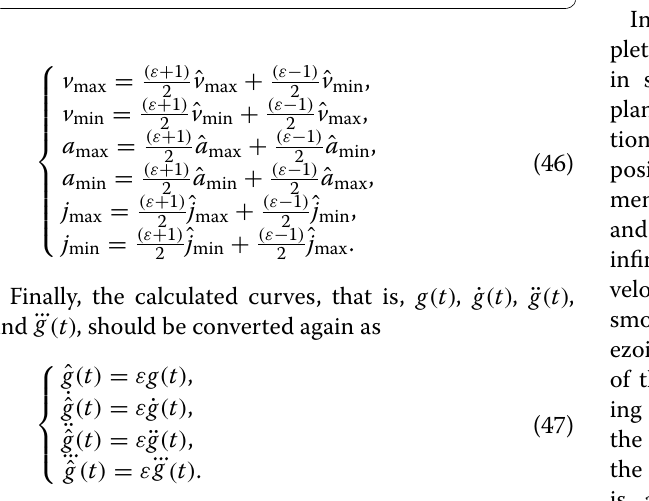
Figure 15 Position, velocity, and acceleration curves of double-S velocity curve planning in the Z